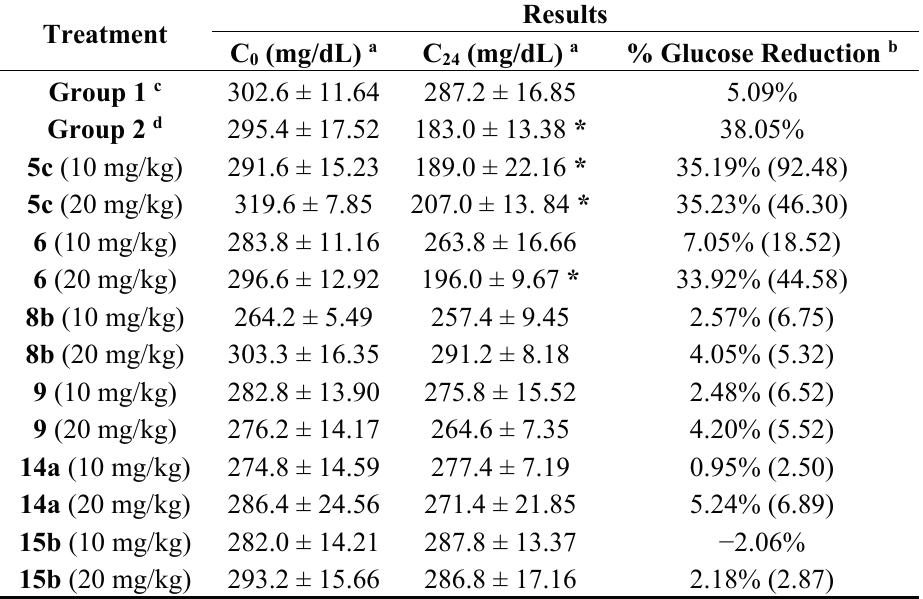
Table 3. Oral hypoglycemic activity of compounds 5c , 6 , 8b , 9 , 14a , 15b (10 and 20 mg/kg) and gliclazide (10 mg/kg) in STZ-induced diabetic